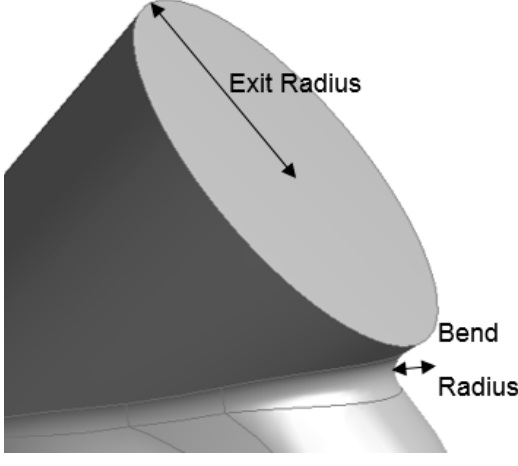
Figure 12. Volute exit parameters.